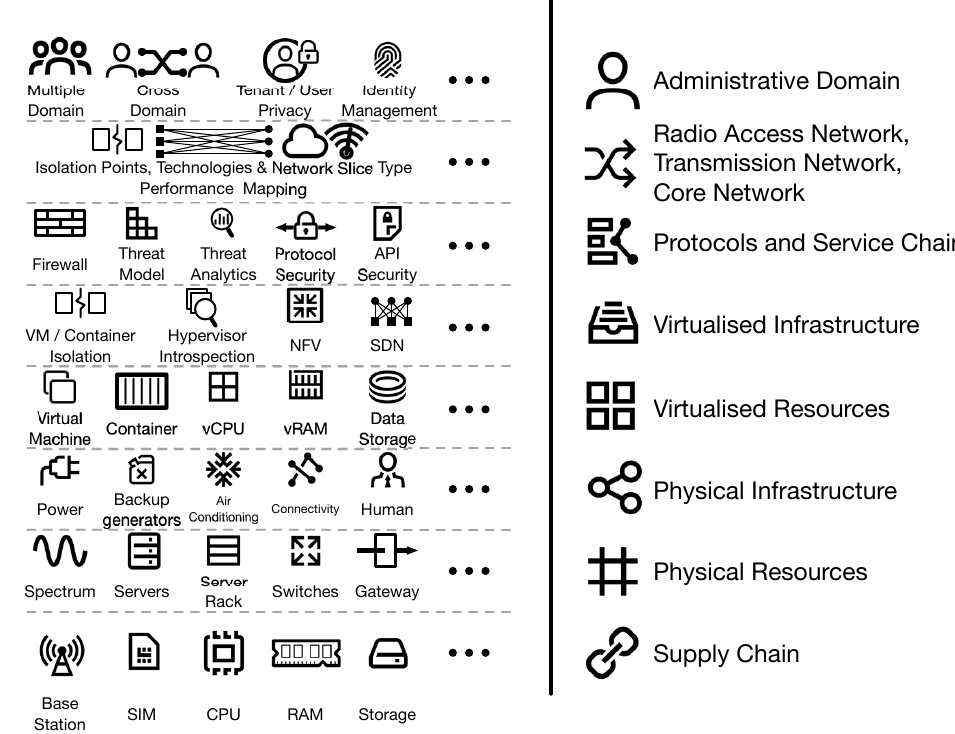
Figure 1. Network slice basic